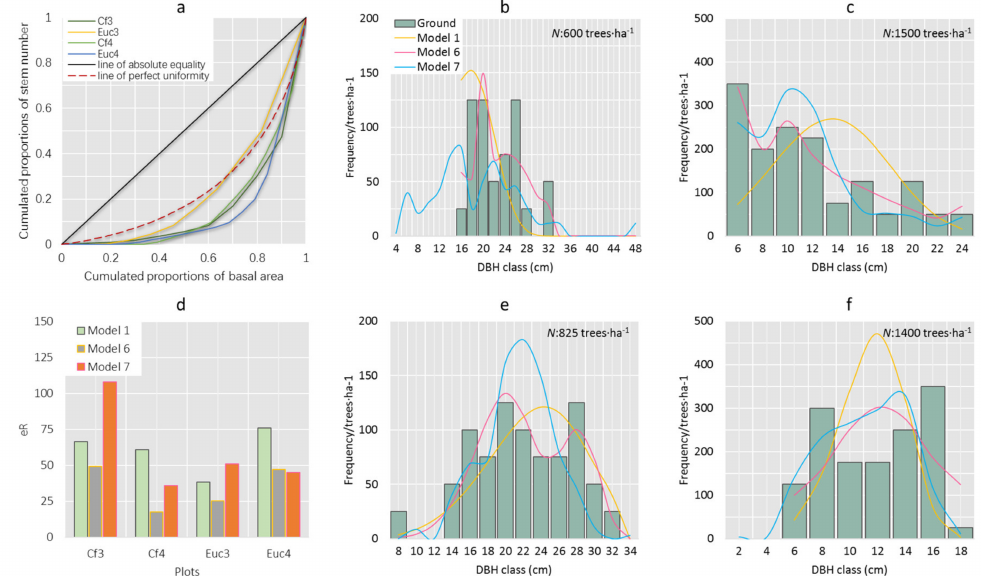
Figure 8. The ground diameter distributions of four differentiated multimodal sample plots with relative low ( b , e ) and high stem density ( c , f ) predicted by Model 1, Model 6 and Model 7. ( a ) The Lorenz curves of four sample plots; ( b , c ) Chinese fir plots; ( e , f ) Eucalypt plots; ( d ) The Reynolds error index of predicted diameter distributions of four sample plots. Notes: Cf3 and Cf4 = Chinese fir plot 3 ( b ) and 4 ( c ); Euc3 and Euc4 = Eucalypt plot 3 ( e ) and 4 ( f ); Model 1 = Unimodal Weibull model for undifferentiated all plots; Model 6 = FMM for differentiated multimodal plots; Model 7 = KNN model for all